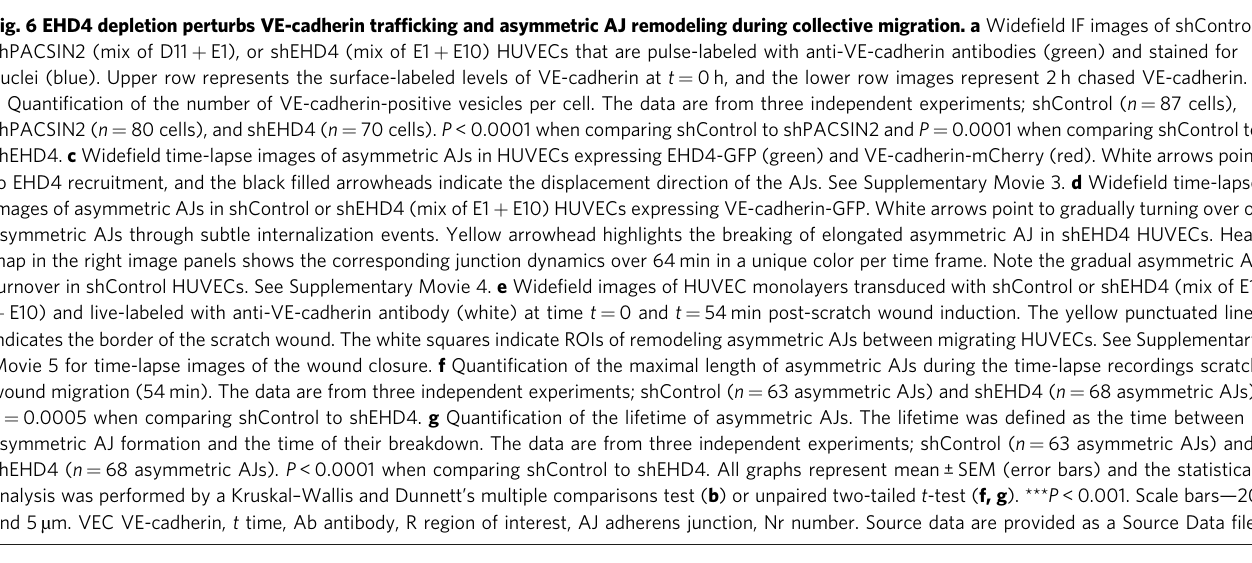
Fig. 6 EHD4 depletion perturbs VE-cadherin traf fi cking and asymmetric AJ remodeling during collective migration. a Wide fi eld IF images of shControl, shPACSIN2 (mix of D11 + E1), or shEHD4 (mix of E1 + E10) HUVECs that are pulse-labeled with anti-VE-cadherin antibodies (green) and stained for nuclei (blue). Upper row represents the surface-labeled levels of VE-cadherin at t = 0 h, and the lower row images represent 2 h chased VE-cadherin. b Quanti fi cation of the number of VE-cadherin-positive vesicles per cell. The data are from three independent experiments; shControl ( n = 87 cells), shPACSIN2 ( n = 80 cells), and shEHD4 ( n = 70 cells). P < 0.0001 when comparing shControl to shPACSIN2 and P = 0.0001 when comparing shControl to shEHD4. c Wide fi eld time-lapse images of asymmetric AJs in HUVECs expressing EHD4-GFP (green) and VE-cadherin-mCherry (red). White arrows point to EHD4 recruitment, and the black fi lled arrowheads indicate the displacement direction of the AJs. See Supplementary Movie 3. d Wide fi eld time-lapse images of asymmetric AJs in shControl or shEHD4 (mix of E1 + E10) HUVECs expressing VE-cadherin-GFP. White arrows point to gradually turning over of asymmetric AJs through subtle internalization events. Yellow arrowhead highlights the breaking of elongated asymmetric AJ in shEHD4 HUVECs. Heat map in the right image panels shows the corresponding junction dynamics over 64 min in a unique color per time frame. Note the gradual asymmetric AJ turnover in shControl HUVECs. See Supplementary Movie 4. e Wide fi eld images of HUVEC monolayers transduced with shControl or shEHD4 (mix of E1 + E10) and live-labeled with anti-VE-cadherin antibody (white) at time t = 0 and t = 54 min post-scratch wound induction. The yellow punctuated line indicates the border of the scratch wound. The white squares indicate ROIs of remodeling asymmetric AJs between migrating HUVECs. See Supplementary Movie 5 for time-lapse images of the wound closure. f Quanti fi cation of the maximal length of asymmetric AJs during the time-lapse recordings scratch wound migration (54 min). The data are from three independent experiments; shControl ( n = 63 asymmetric AJs) and shEHD4 ( n = 68 asymmetric AJs). P = 0.0005 when comparing shControl to shEHD4. g Quanti fi cation of the lifetime of asymmetric AJs. The lifetime was de fi ned as the time between asymmetric AJ formation and the time of their breakdown. The data are from three independent experiments; shControl ( n = 63 asymmetric AJs) and shEHD4 ( n = 68 asymmetric AJs). P < 0.0001 when comparing shControl to shEHD4. All graphs represent mean ± SEM (error bars) and the statistical analysis was performed by a Kruskal – Wallis and Dunnett ’ s multiple comparisons test ( b ) or unpaired two-tailed t -test ( f, g ). *** P < 0.001. Scale bars — 20 and 5 µ m. VEC VE-cadherin, t time, Ab antibody, R region of interest, AJ adherens junction, Nr number. Source data are provided as a Source Data fi